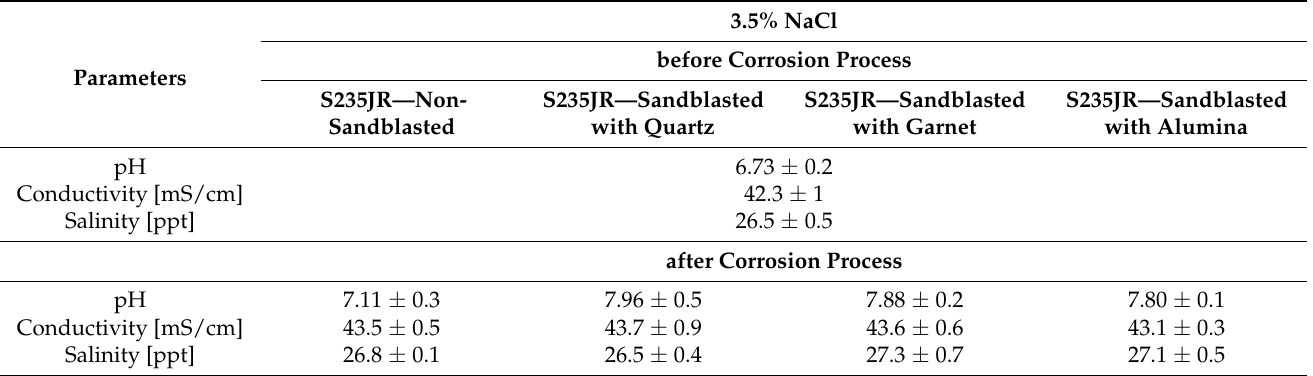
Table 3. Physical-chemical parameters of 3.5% NaCl solution before and after the corrosion process.